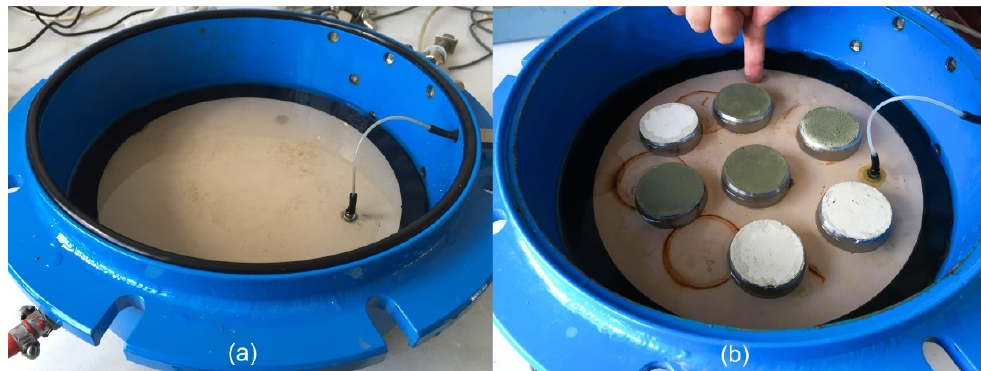
Figure 5. Saturation of ( a ) ceramic disc and ( b ) compacted samples in 15-bar pressure plate cell.